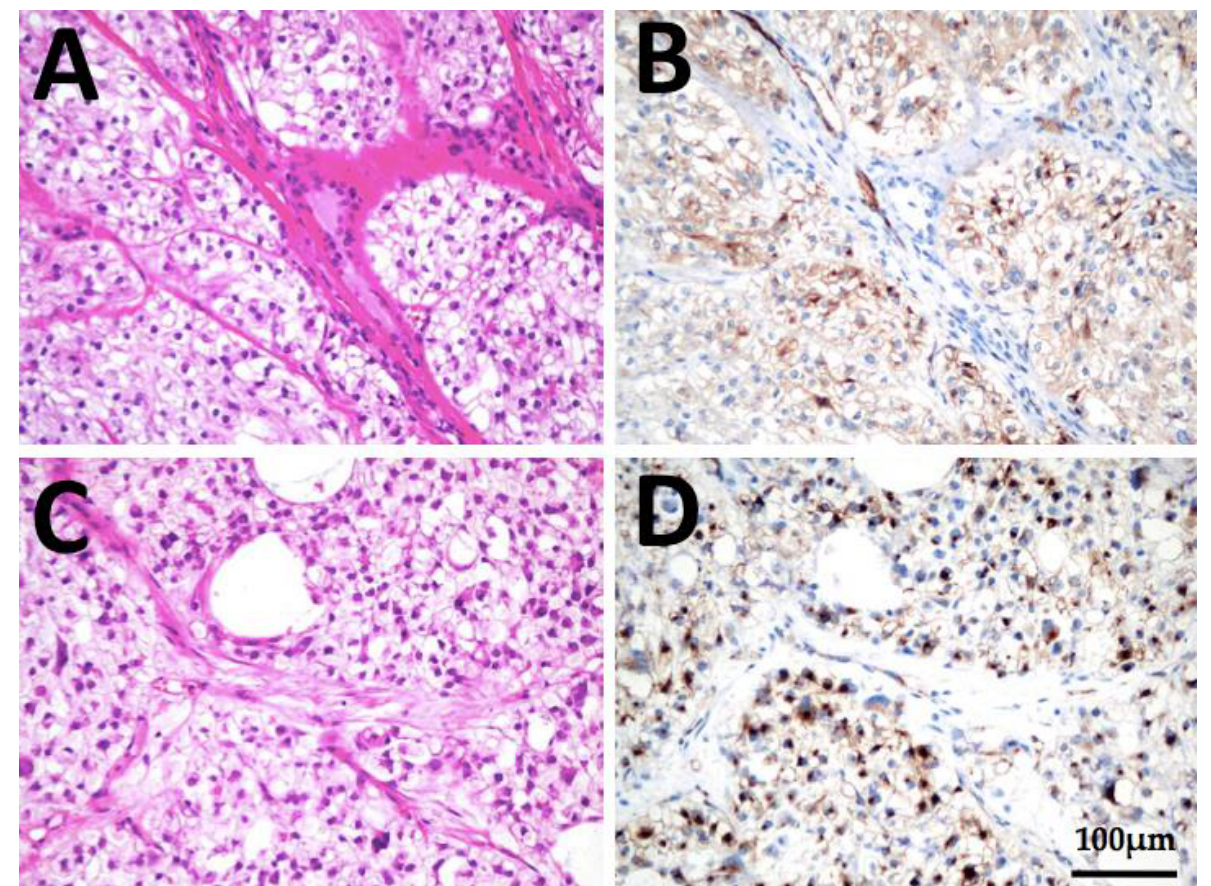
Figure 10. Immunohistochemistry of a patient with PDTC. ( A , B ), histology of PDTC thyroidal primary tumor and ( C , D ) cervical lymph node metastasis in HE staining and PSMA immunohistochemistry, respectively. Strong membraneous and cytoplasmatic immunoreactivity of tumor cells can be seen at both localizations (PSMA-labelling index 3). Scale bar, 100 µm, respectively.